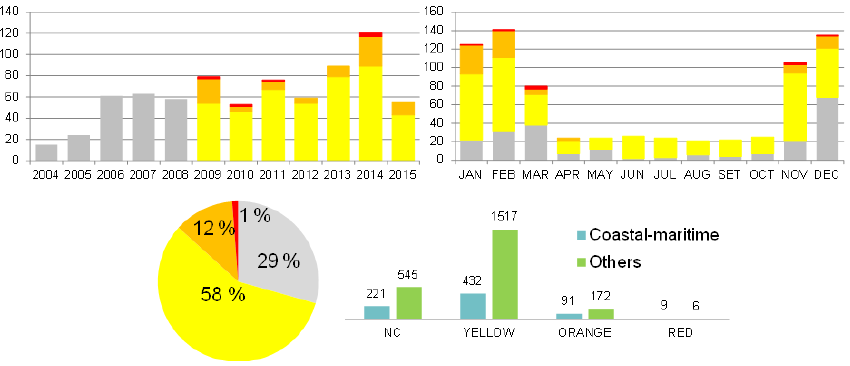
Figure 4. Yearly and monthly distribution of coastal–maritime warnings (April 2004–June 2015) in Basque Country, total distribution of warnings, and relative importance of oceanic and meteorological causes in the total warning system (from left to right and top to bottom